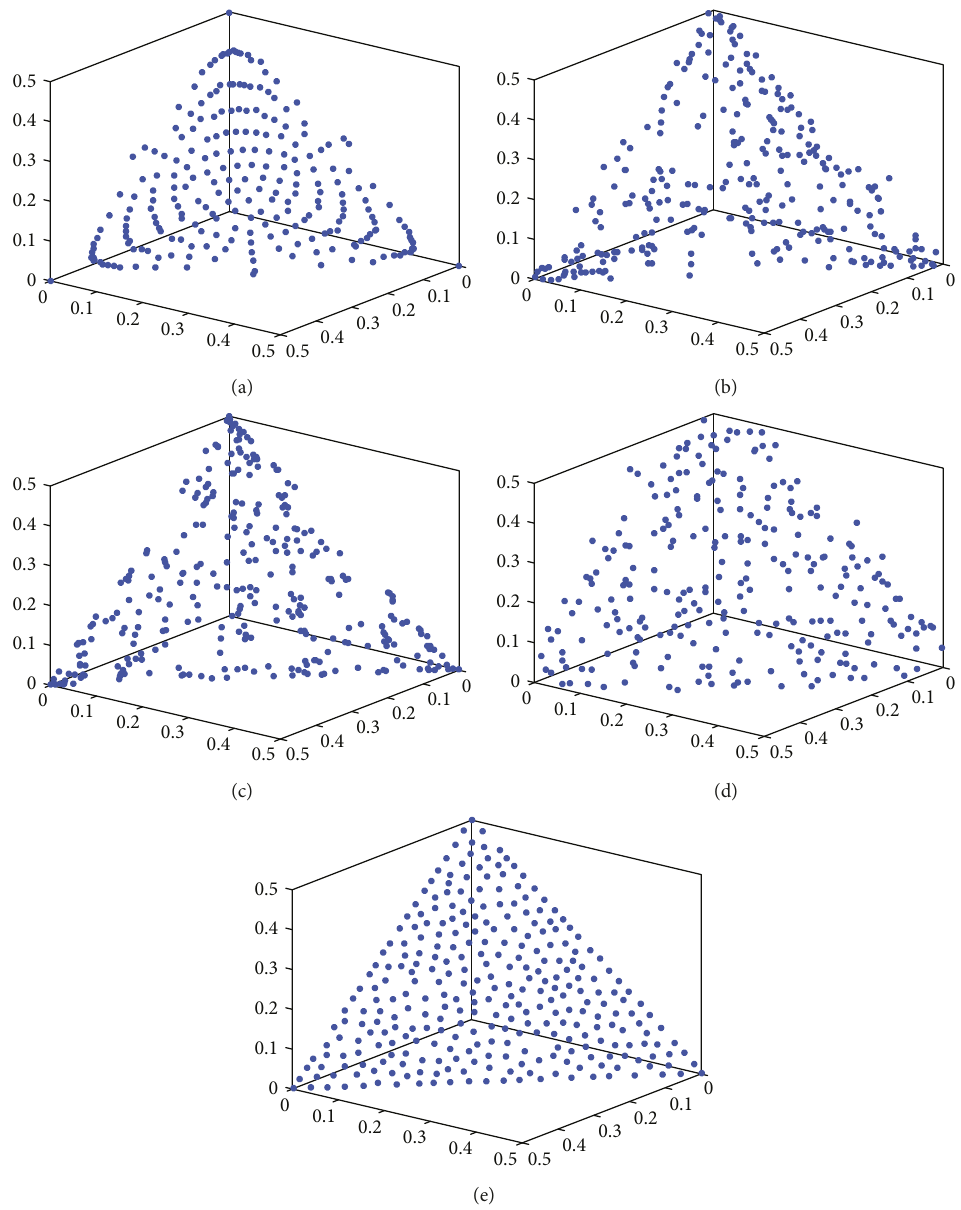
Figure 8: The typical Pareto front obtained by 5 algorithms on DTLZ1. (a) MOEA/D, (b) NSGA-II, (c) NNIA, (d) MODE, and (e)